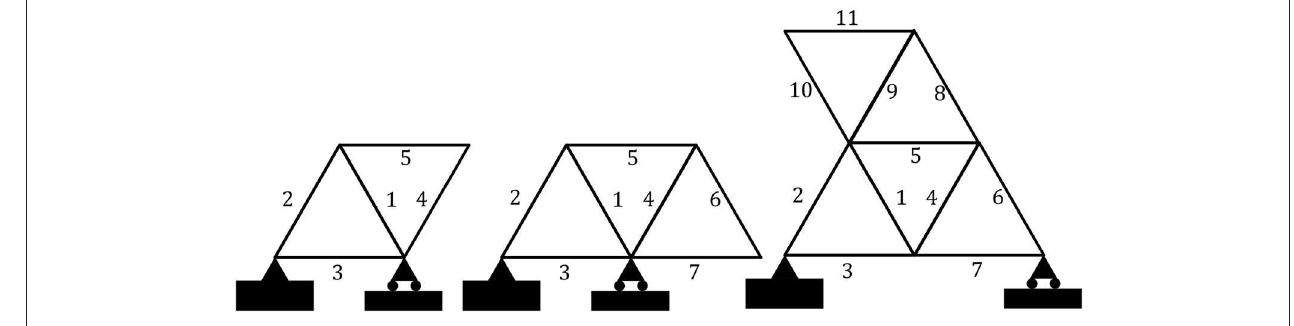
FIGURE 5 | Examples of frameworks with independent elements.